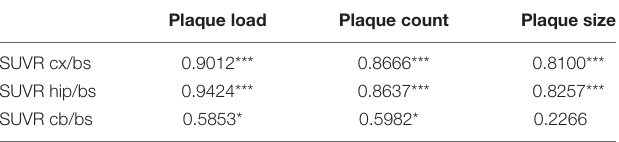
Pearson correlation coefficient (r) is shown for each pairwise correlation. Bs, brain stem; cb, cerebellum; cx, cortex; hip, hippocampus. ∗ p < 0.05, ∗∗∗ p <